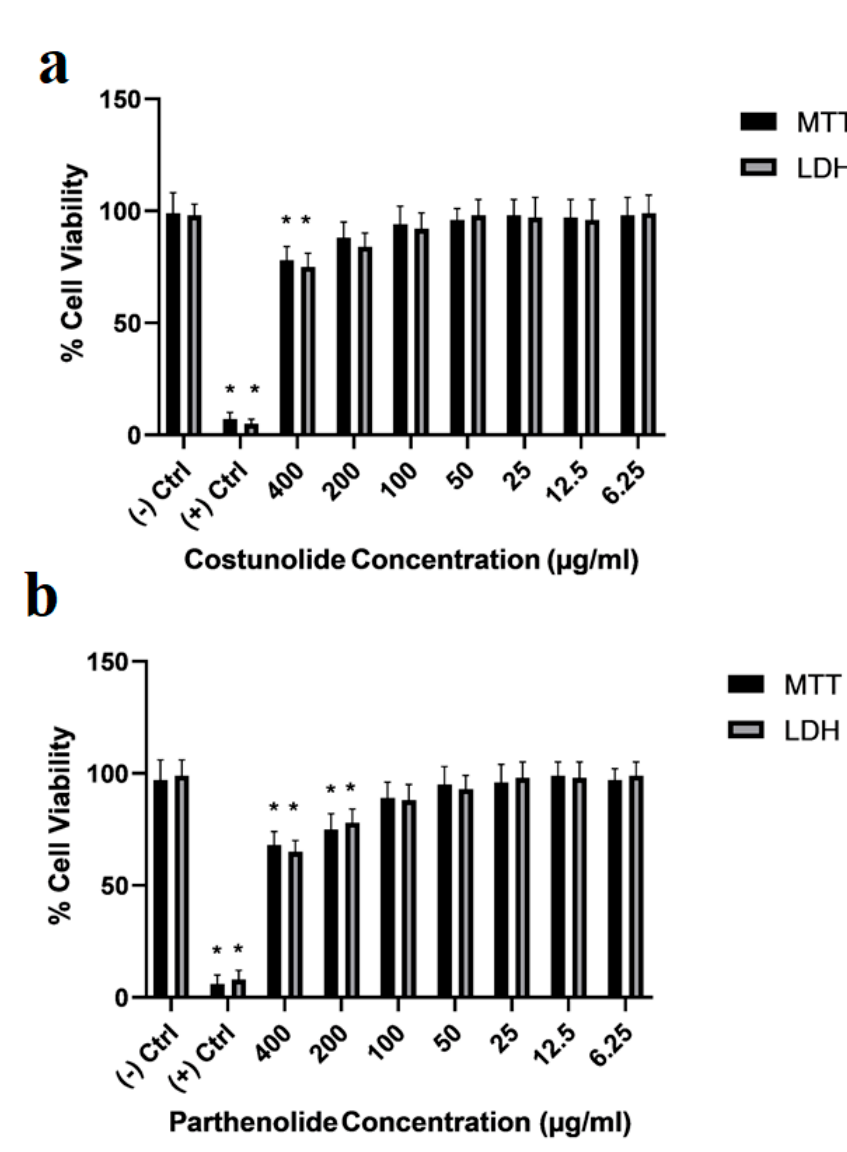
Figure 9. Viability rates of differentiated SHSY-5Y cells treated with ( a )—costunolide and ( b )—parthen- olide terpenoids for 24 h are presented. ( − ) Ctrl: Negative control, (+) Ctrl: Positive control (Triton-X). Statistical significance compared to negative control was shown (*) p < 0.05. (GraphPad Prism ® version 7.0, Two-way ANOVA and Tukey’s post hoc test were used to compare the means of different treatments to determine significant difference ( p <